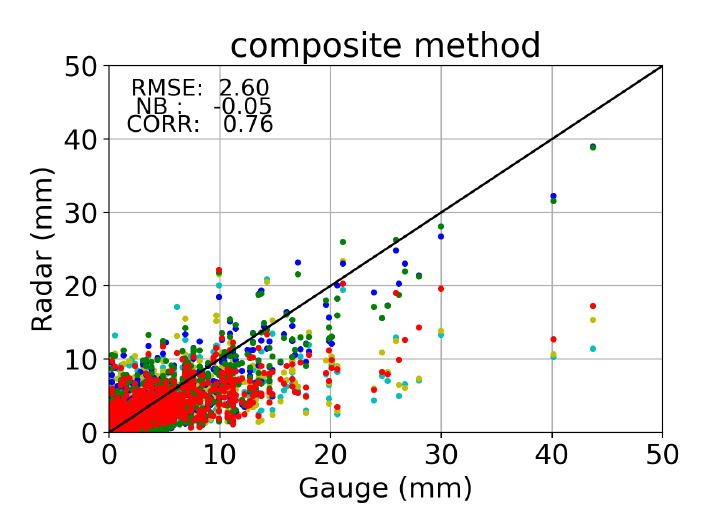
Figure 2. Comparison between hourly rain amounts of RG and radar rain rates. The blue, cyan, yellow, green, and red dots represent the rain rates by R ( K dp ) , R ( Z h ) , R ( Z h , Z dr ) , R ( Z h , Z dr , K dp ) , and the composite method,